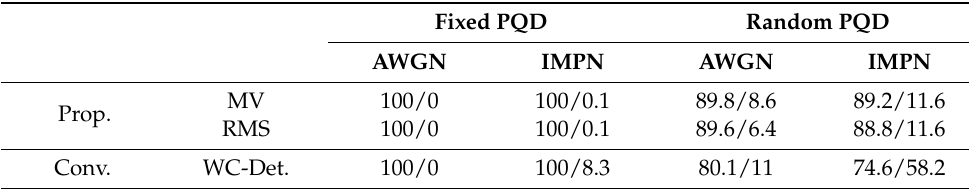
Table 4. Single-edge-based PQD detection performance (DR/FER (%)) of the proposed and conven- tional wavelet-correlation-based-detection (WC-Det) algorithms, where a swell signal with 120% pu is used over Gaussian noise (AWGN) with signal-to-noise ratio (SNR) = 35 dB or IMPN with SNR = 35 dB, µ = 400, ψ = 0.02%. Fixed PQD Random PQD AWGN IMPN AWGN IMPN MV 100/0 100/0.1 89.8/8.6 89.2/11.6 Prop. RMS 100/0 100/0.1 89.6/6.4 88.8/11.6 Conv. WC-Det. 100/0 100/8.3 80.1/11